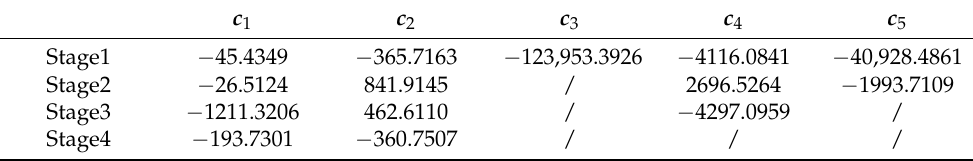
Table 14. Values of fitness function at different stages of the Page-blocks data set.